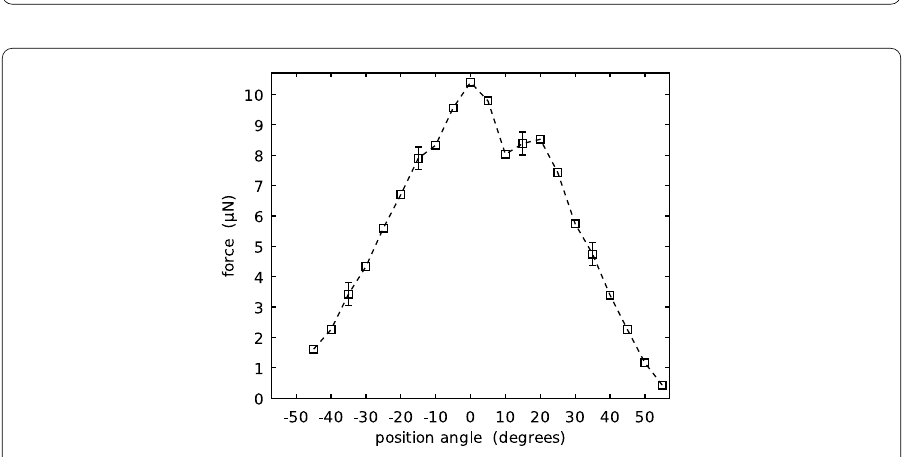
Figure 5 Force profile of the HEMP thruster operated in the “Low I sp Mode” (350 V discharge voltage, 245 mA discharge current, 4 sccm Xe gas flow)